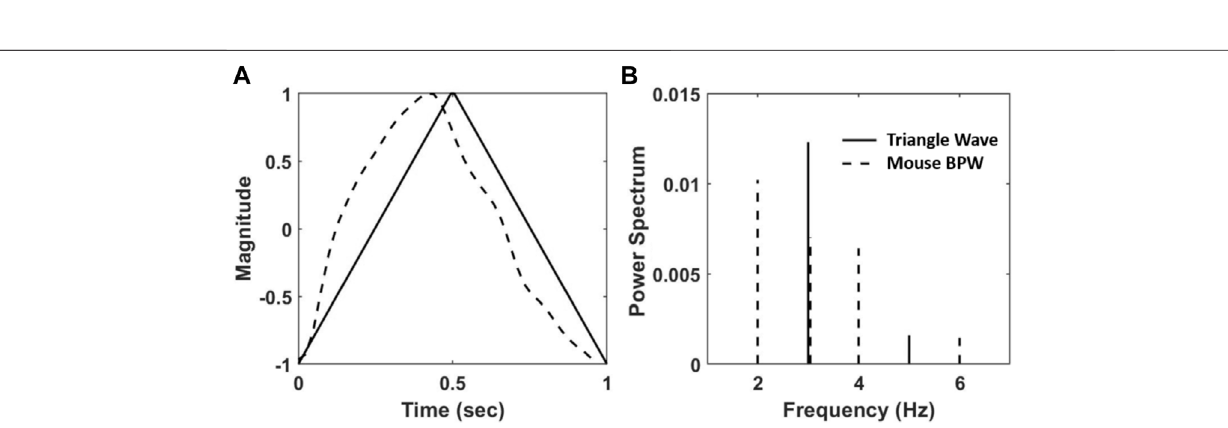
( Figure 2A ) using a custom MATLAB code according to Eq. 1 and plotted in Figure 2B . The triangle wave has a HD value of 0.014 whereas the sample BPW waveform is more distorted with an HD value of 0.025.